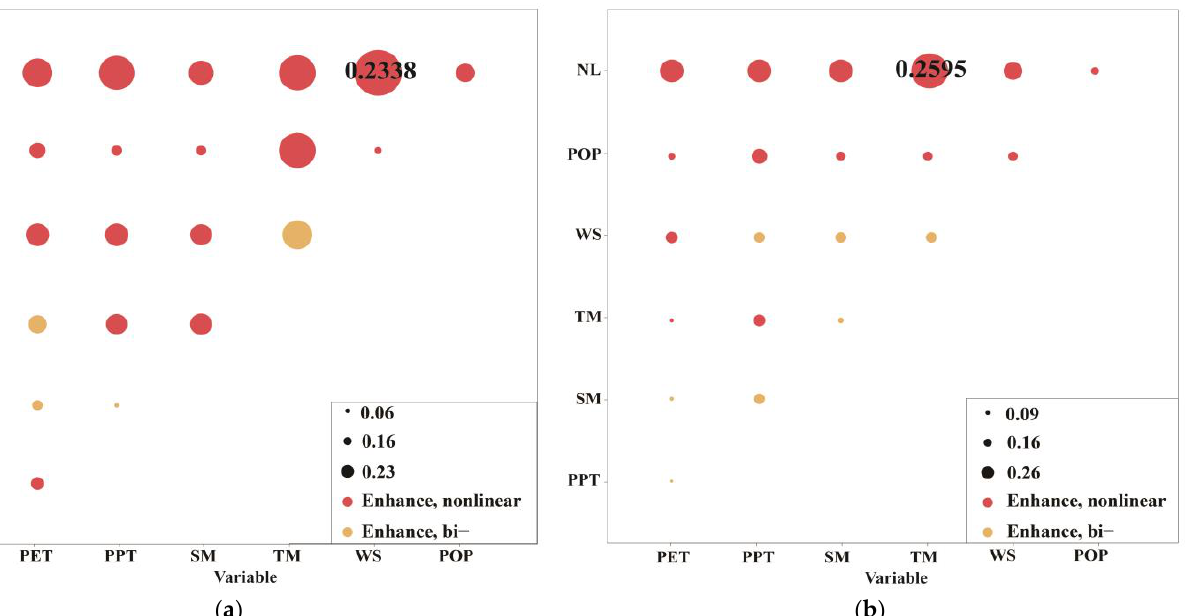
Figure 10. PD value of desertification drivers. ( a ) East Ujimqin Banner; ( b ) the three counties in Mongolia.